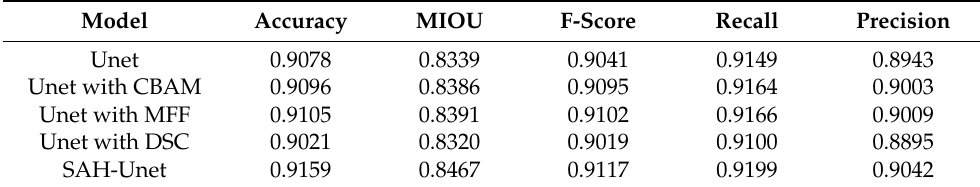
Table 5. Comparison table of the test accuracy of different Unet models.